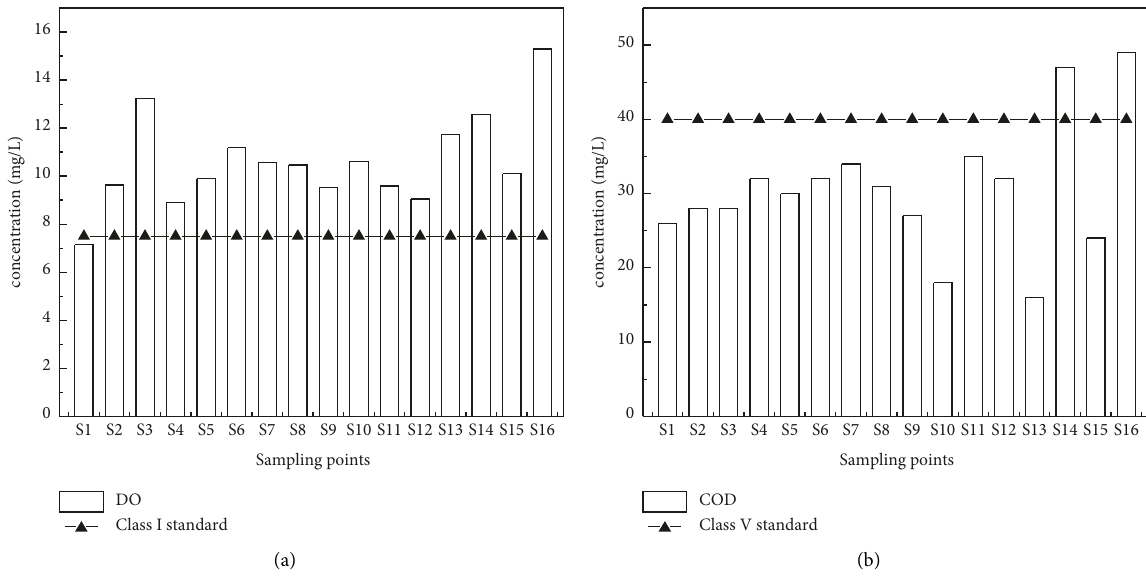
Figure 3: The content of DO (a) and COD (b) at each sampling point in the Huainan coal mining subsidence water bodies.